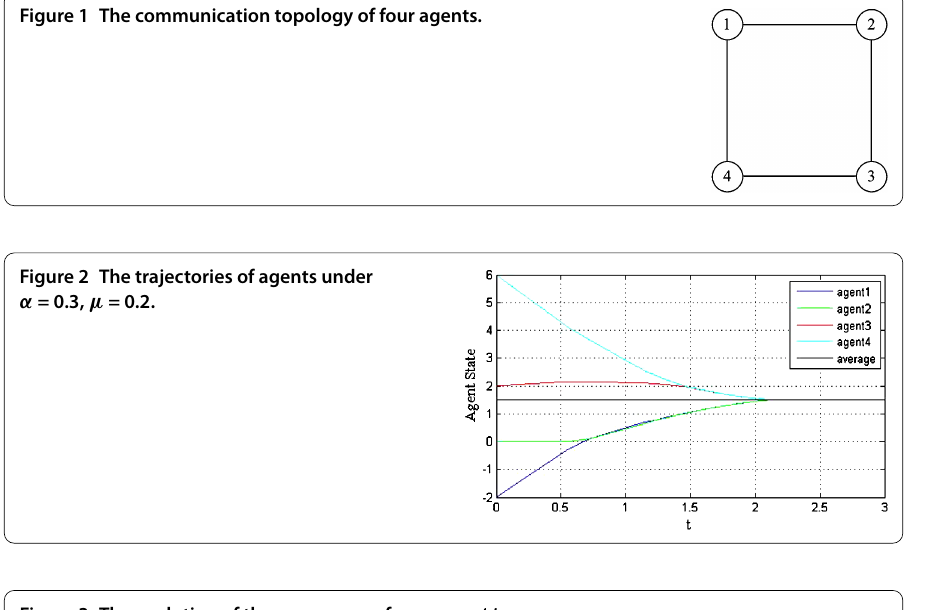
Figure 3 The evolution of the error norm of agent 1 under α = 0.3, μ = 0.2.